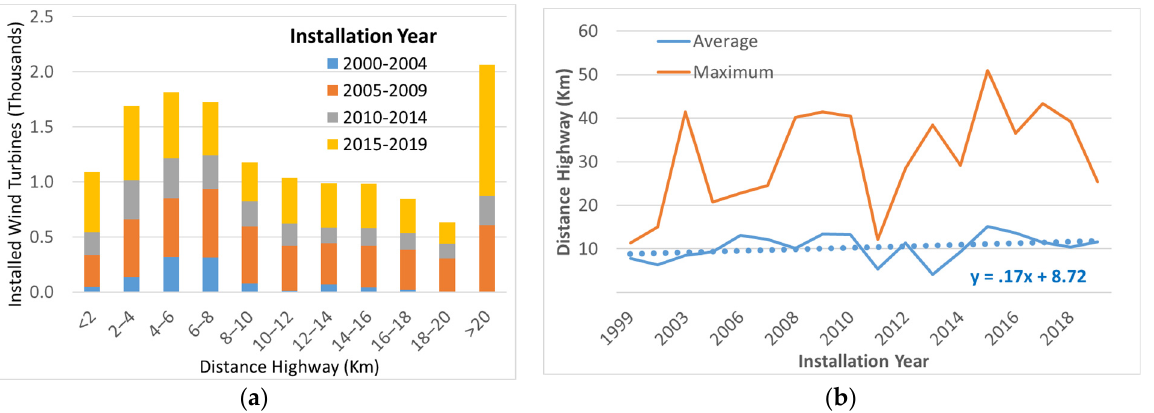
Figure 13. Distance from wind turbines in Texas to closest major highways over time. ( a ) Number of wind turbines. ( b ) Maximum and average distance from wind turbines.